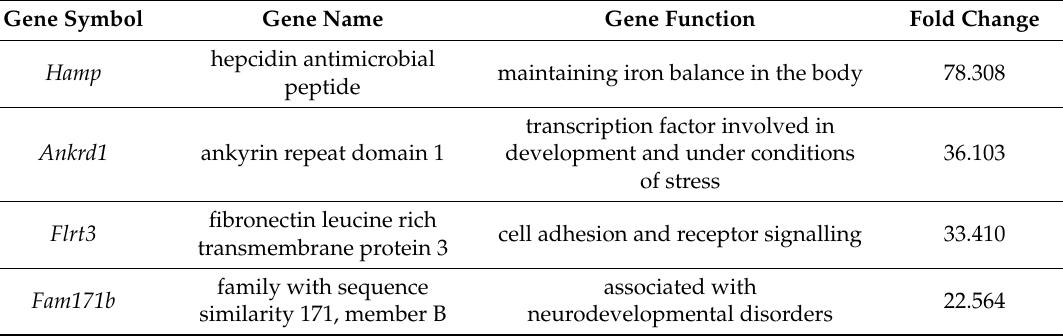
Table 2. The list of 15 the most upregulated genes in bortezomib-treated PC12-derived nerve cells compared to